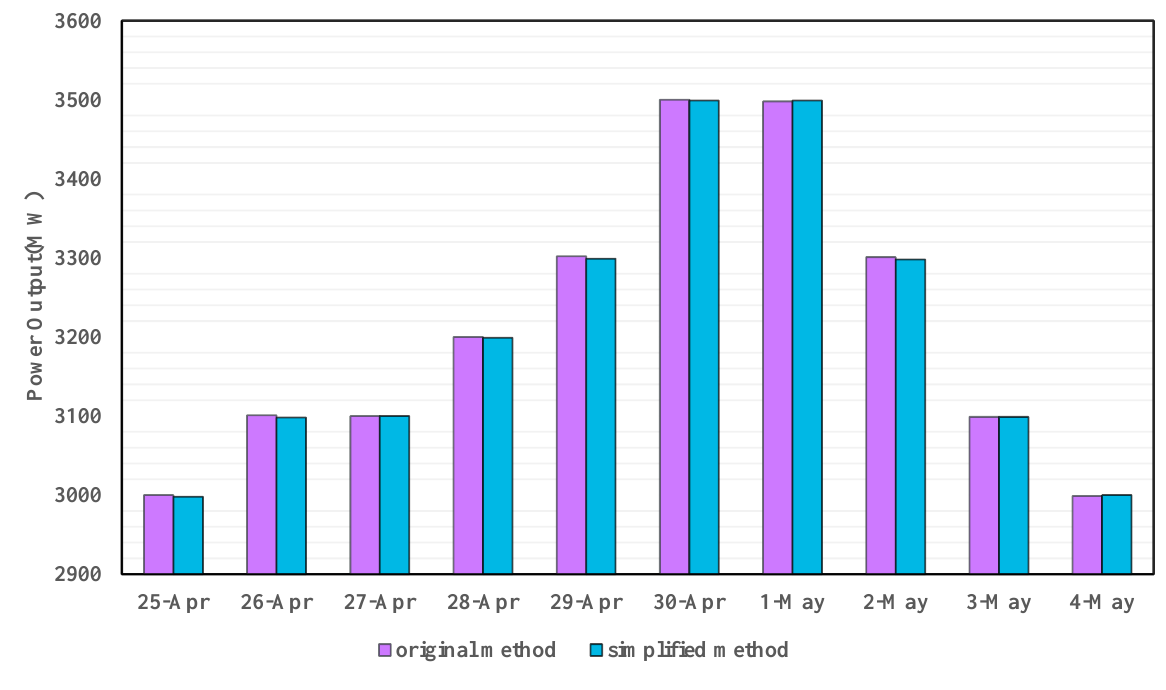
Figure 3. Power Output Process of Cascaded Hydropower System Obtained by Original Method and Simplified Method.